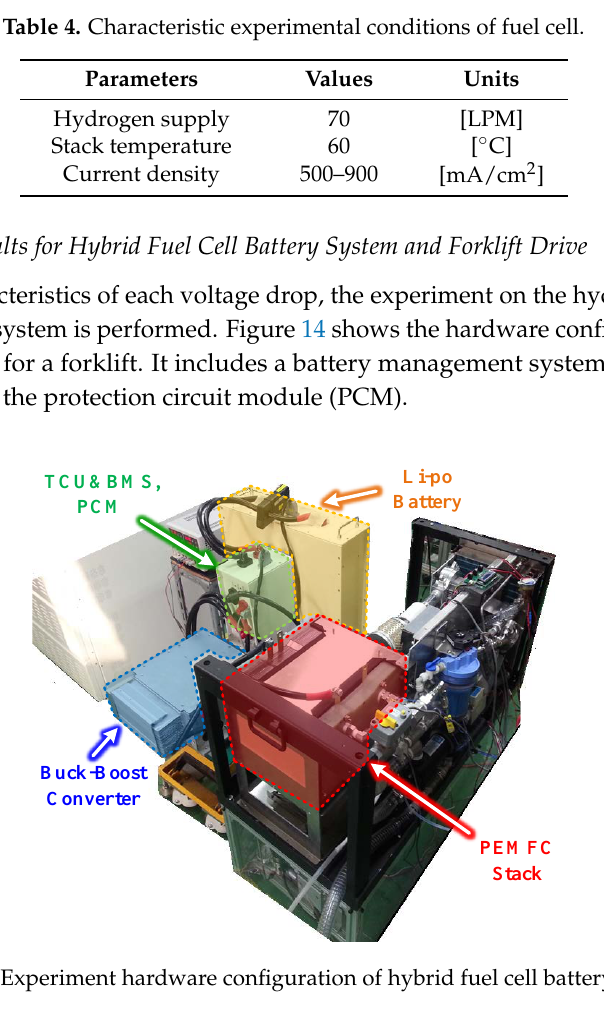
Figure 16. Output waveforms of lithium polymer battery during hydrogen recirculation. Figure 17a shows the forklift with hybrid fuel cell battery system. The experimental method is lifting a 5 ton weight and driving at 25 km/h. The drive experiment of forklift was repeated six times. Figure 17b shows the total output current of the hybrid fuel cell battery system flowing through the inverter, while the forklift operates; when lifting 5 tons and driving at 25 km/h, the forklift requires a current of 300 A or more maximally. However, it can be seen that the hybrid fuel cell battery system works normally without the shutdown during hydrogen recirculation, thanks to the proposed voltage drop compensation method.